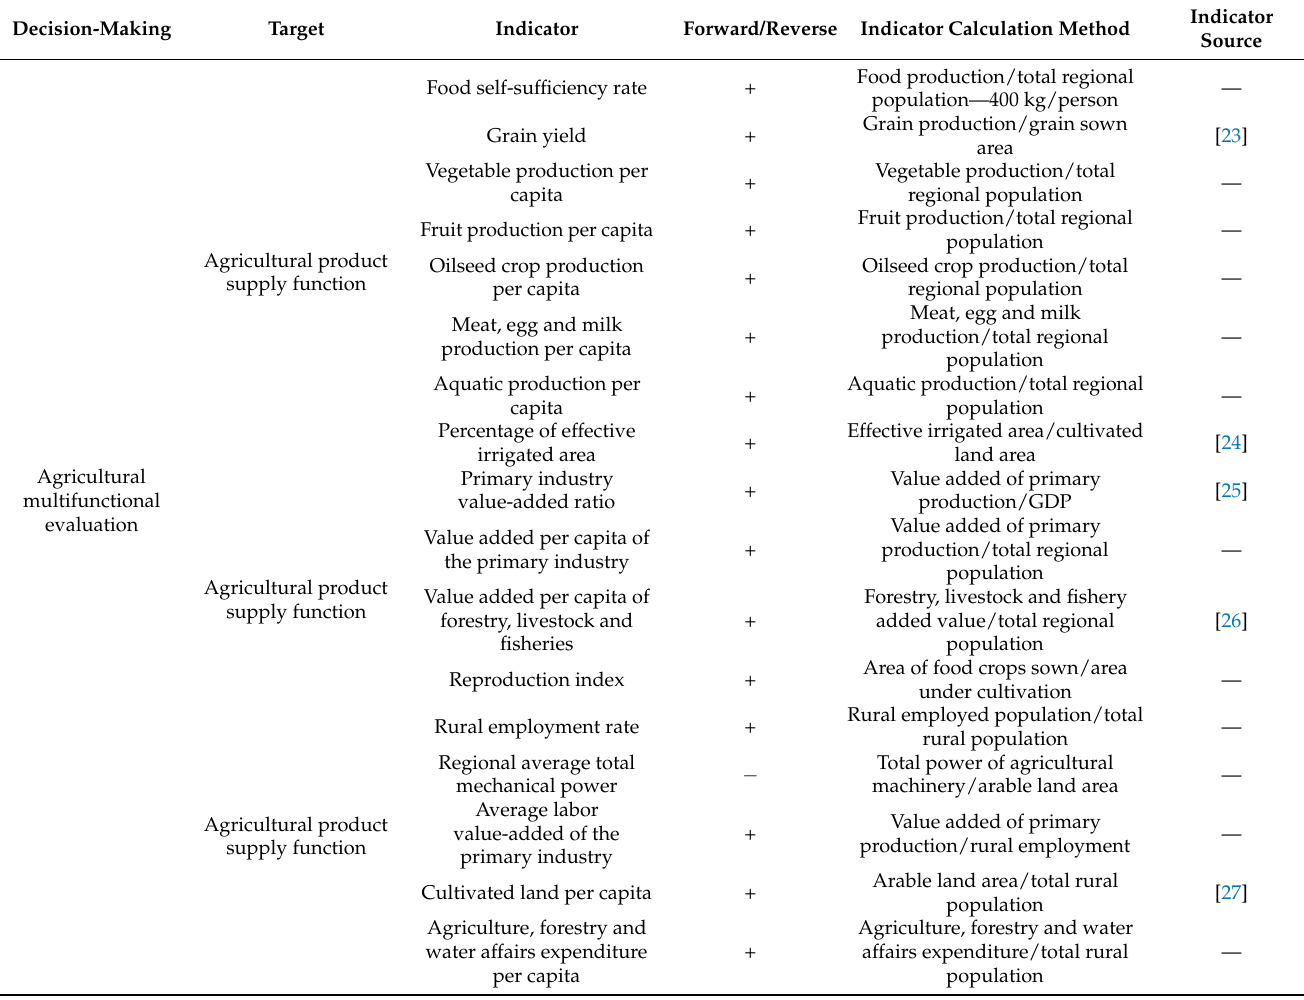
Table 1. Index system of agricultural multifunctionality